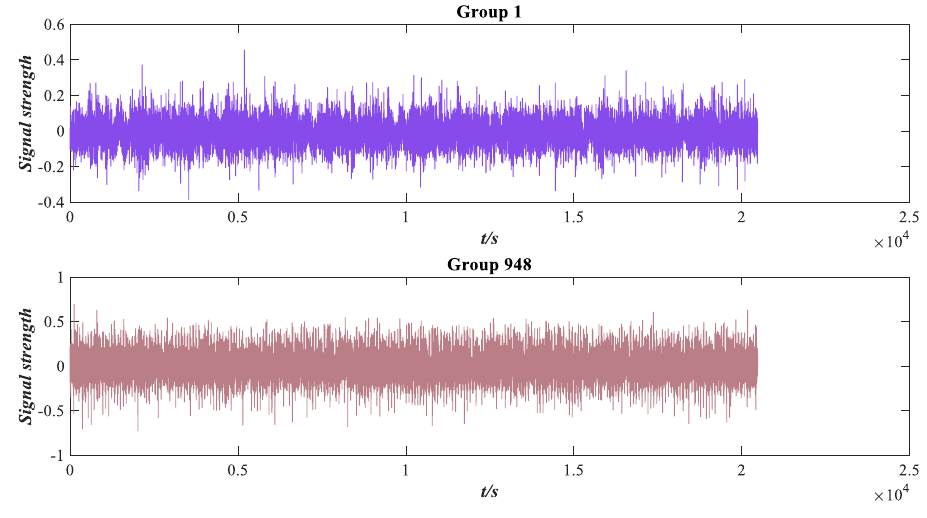
Figure 4. Vibration signal distribution.